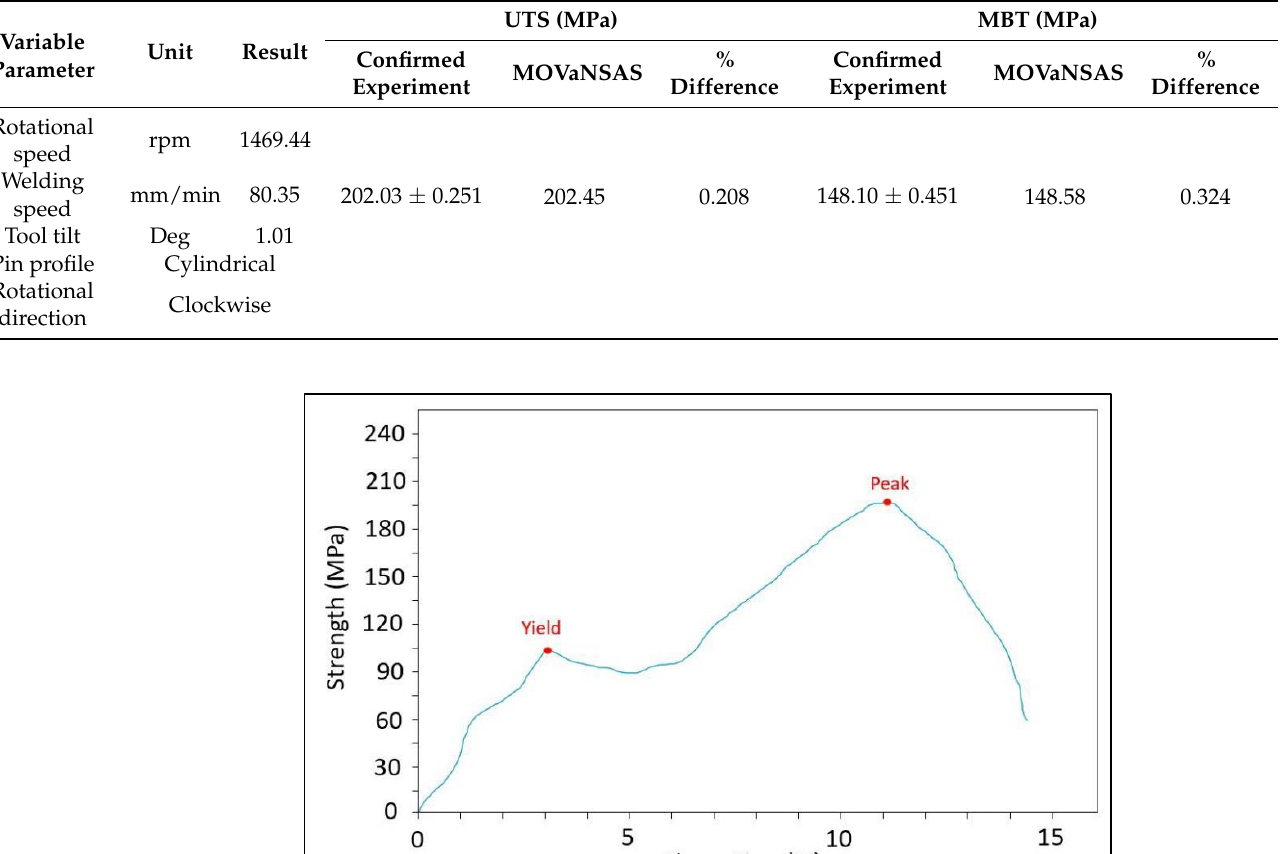
Figure 7. Quality of the weld line based on the relationship between tensile strength and elongation percentage.